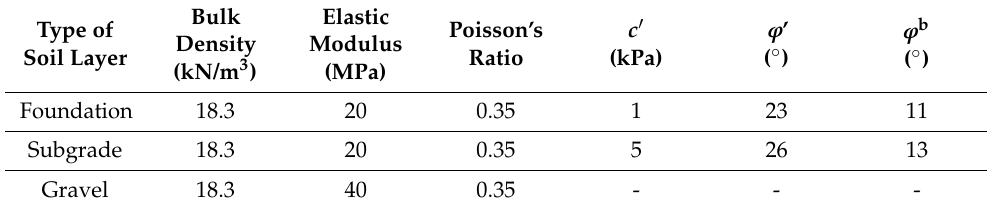
Table 2. Strength properties of the various soils for the subgrade with a capillary barrier.